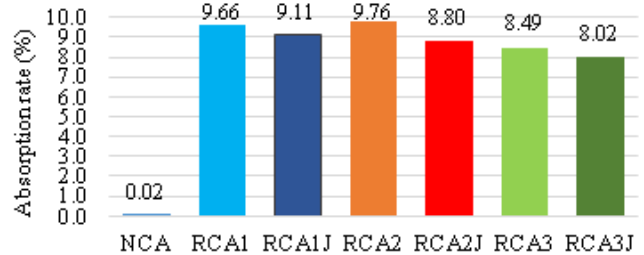
Figure 7. Absorption rate of the natural and recycled coarse